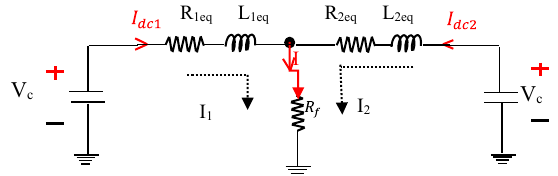
Fig. 11 Modified circuit for P-P-G fault